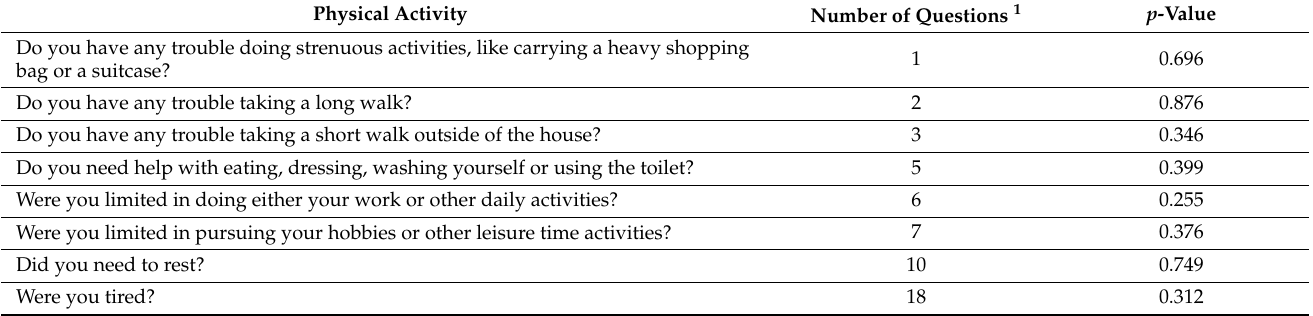
Table 3. The impact of the location of the tumor (ovaries, breasts) on selected aspects of physical